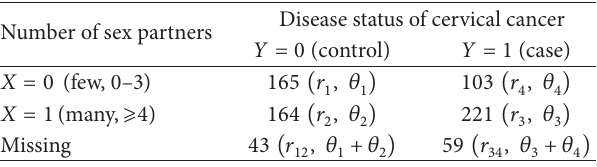
Table 7: Cervical cancer data from Williamson and Haber [17]. Disease status of cervical Number of sex partners